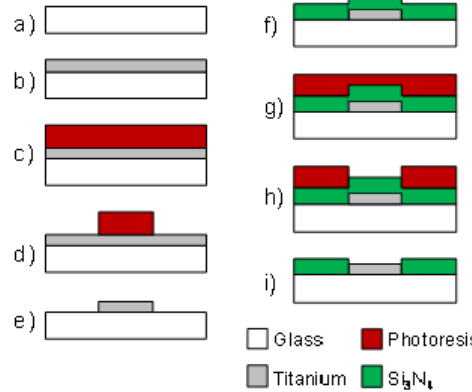
Figure 1. Fabrication process of tMEAs: (a) Bulk glass wafer; (b) Titanium coating; (c) Photoresist coating; (d) UV-exposure and development; (e) Wet etching and resist N ; (g) Photoresist coating; (h) UV-exposure and removal; (f) PECVD deposition of Si 3 4 development; and (i) Dry etching and resist removal. Images are not to